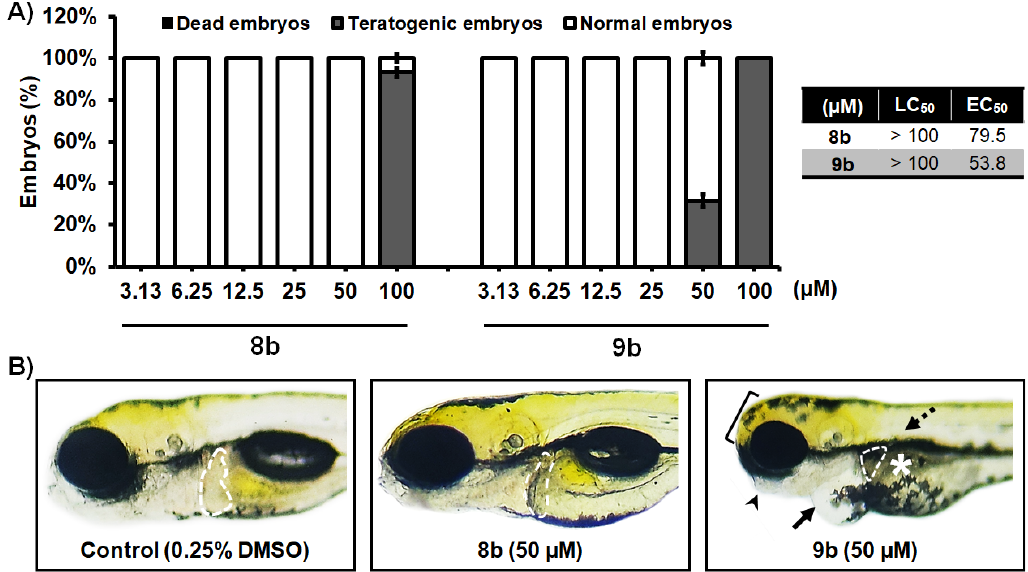
Figure 8. In vivo toxicity assessment of 1-benzhydryl-piperazine-based HDAC inhibitors 8b and 9b in the zebrafish ( Danio rerio ) model. ( A ) Acute toxicity was assessed using wild type (AB) embryos exposed to different doses of tested molecules, and expressed as the LC 50 and EC 50 doses. Embryos were treated at 6 h post fertilization (hpf), and evaluated for survival, teratogenicity, cardiotoxicity, and hepatotoxicity at 120 hpf ( n = 60 per a dose). ( B ) Embryos exposed to 50 µM of 8b were normally developed embryos, without signs of cardiotoxicity, hepatotoxicity, and teratogenicity. On the other hand, treatment with 9b in some embryos provoked pericardial edema (arrow), weakly resorbed yolk (asterisk), malformed head (bracket) and jaw (arrowhead), no inflated swim bladder (dashed arrow), and decreased and dark liver (outlined). No adverse effect on the liver was detected at 50 µM of 8b , while reduced liver size and darkening (necrosis) occurred in embryos exposed to 50 µM of 9b .